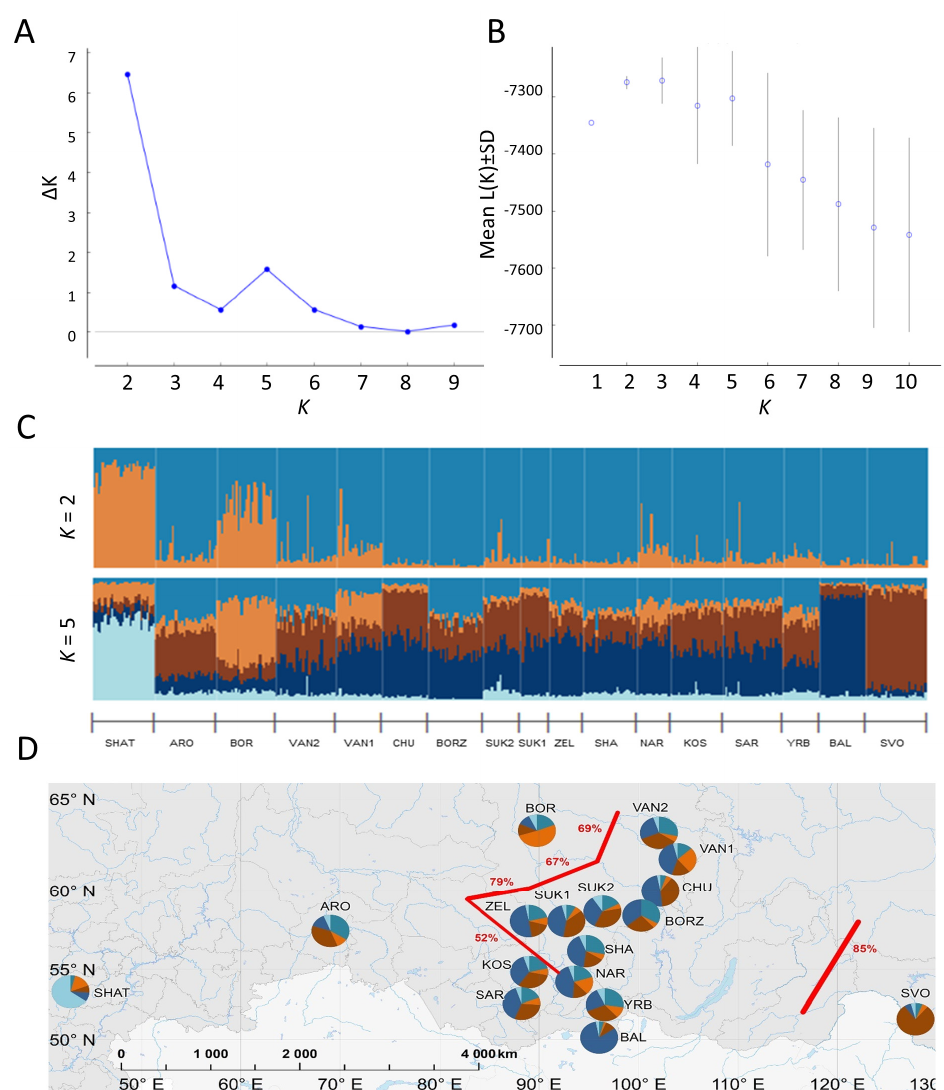
Figure 2. Results of population genetic structure analysis of 17 Scots pine populations (acronyms are as in Table 1). ( A ) Estimated population structure ( K = 2 and K = 5). ( B ) Estimation of the best subpopulation numbers based on ∆ K and Mean L( K ) ± SD values. ( C ) Barplot of genetic structure for K = 2 and K = 5. Light blue, blue, dark blue, orange and brown colors correspond to different clusters. ( D ) Geographic distribution of the five genetic clusters and the two barriers revealed by Barrier analysis (barriers are shown in red bold lines with bootstrap value).